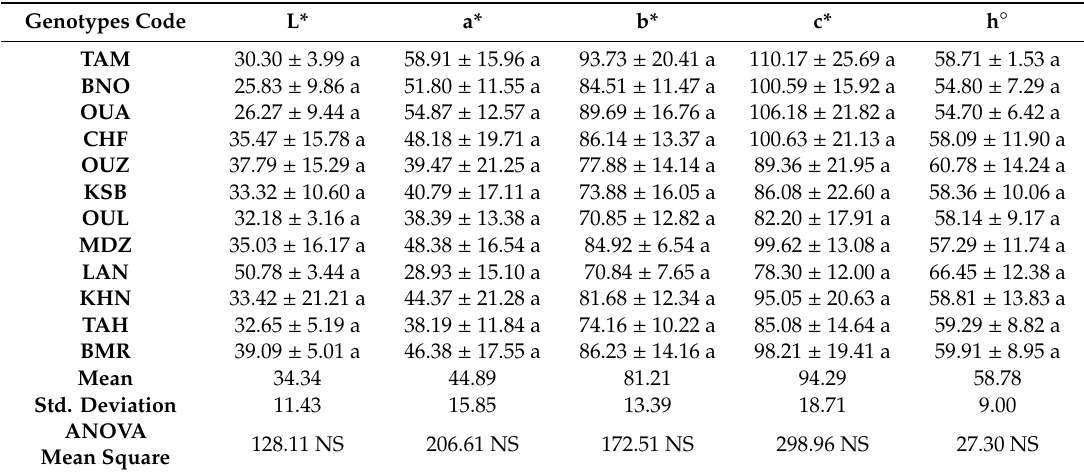
Table 5. Colorimetric characters of twelve strawberry